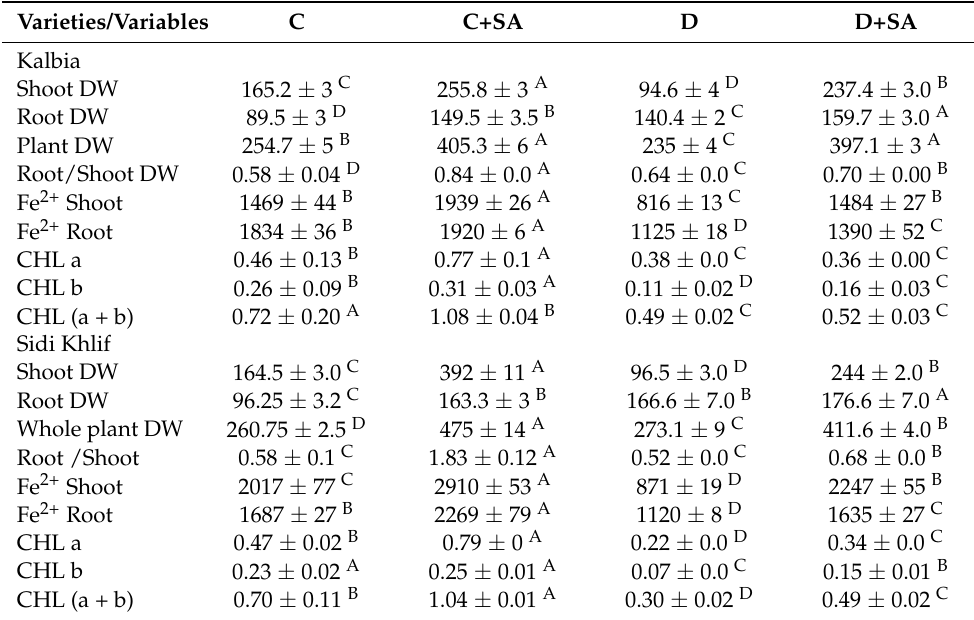
Table 2. Physiological parameters of Sulla carnosa tissues (shoots and roots) in Kalbia and Sidi Khlif primed with SA and grown under different Fe concentrations for 8